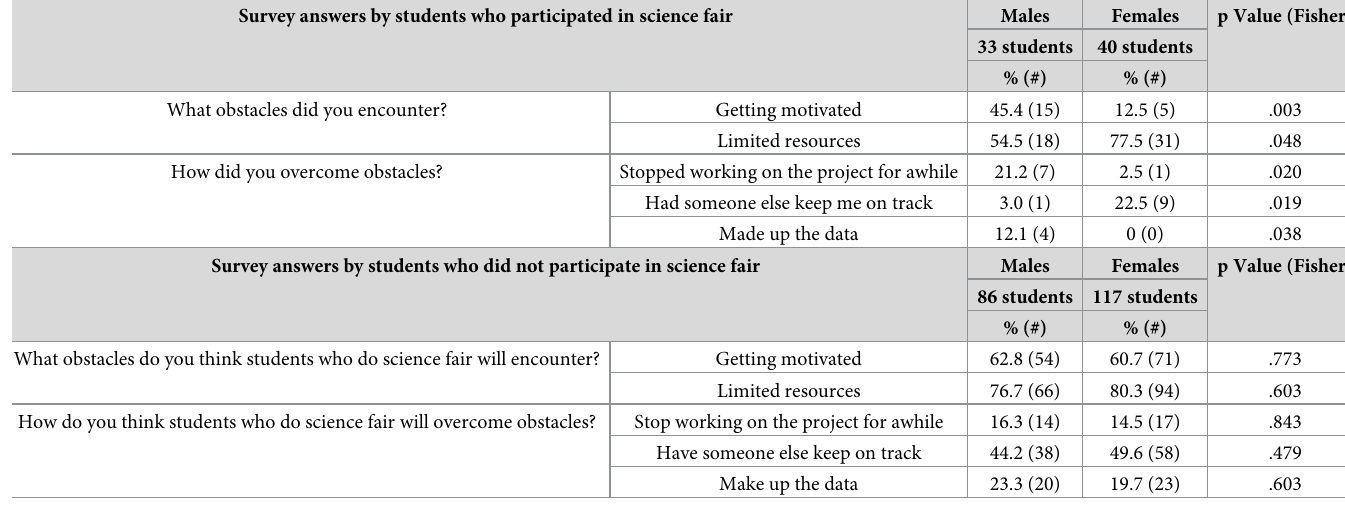
Table 4. Gender differences in SURF student science fair